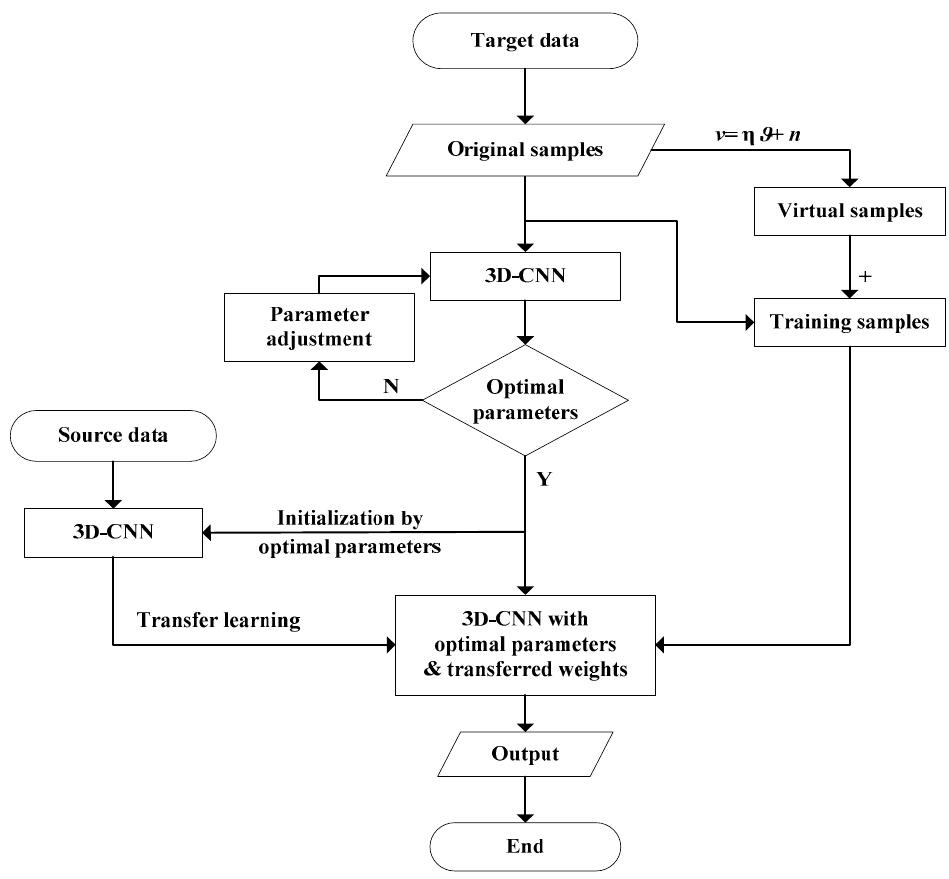
Figure 4. Procedure of the proposed parameter-optimized 3D-CNN combined with transfer learning and virtual samples (PO-3DCNN-TV) and virtual samples (PO-3DCNN-TV) method.